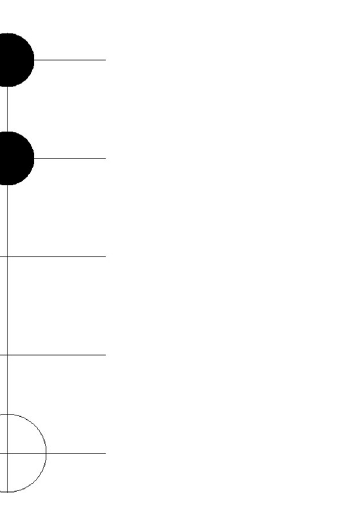
Fig 15. Resulting circuits of No. 18 4gt4_v1 with varying N D : N D = 5.